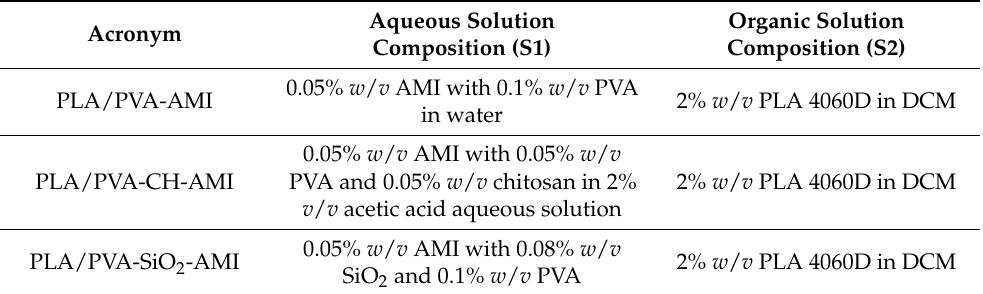
Table 9. Composition of the fabricated material, in